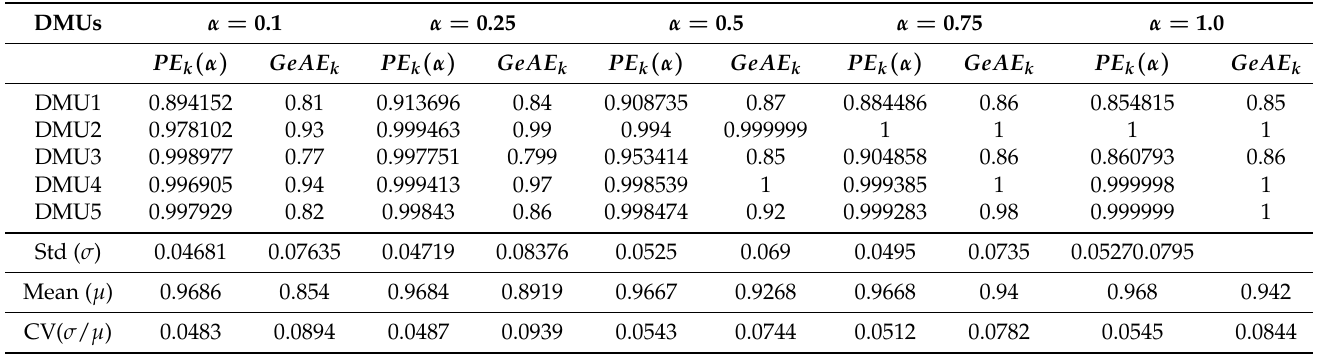
Table 4. Comparison of the proposed method with Wang et al.’s [7] geometric average efficiency method with the help of Coefficient of Variation (CV).